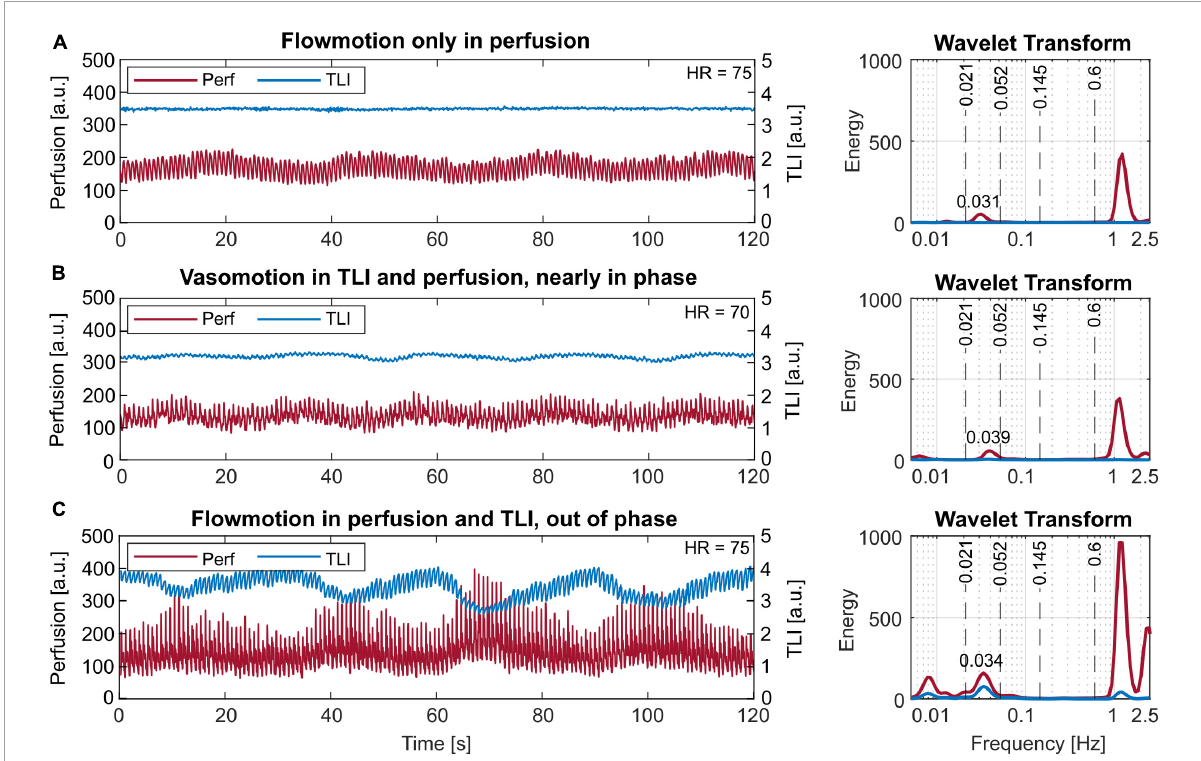
FIGURE7 Short-term (120 s) laser Doppler flowmetry (LDF) data with different vasomotion patterns in the time (left) and frequency (right) domain. (A) Vasomotion only in the perfusion signal. (B) Vasomotion in the perfusion and slightly also the total light intensity (TLI), nearly in phase. (C) Vasomotion both in the perfusion and the TLI, 180 degrees out of phase. The observed rates correspond to 1.86 cycles/min or 0.031 Hz in panel (A) , 2.34 cycles/min or 0.039 Hz in panel (B) , and 2.04 cycles/min or 0.034 Hz in panel (C) . Note the log-scale of the x -axes, used for better visibility in the frequency